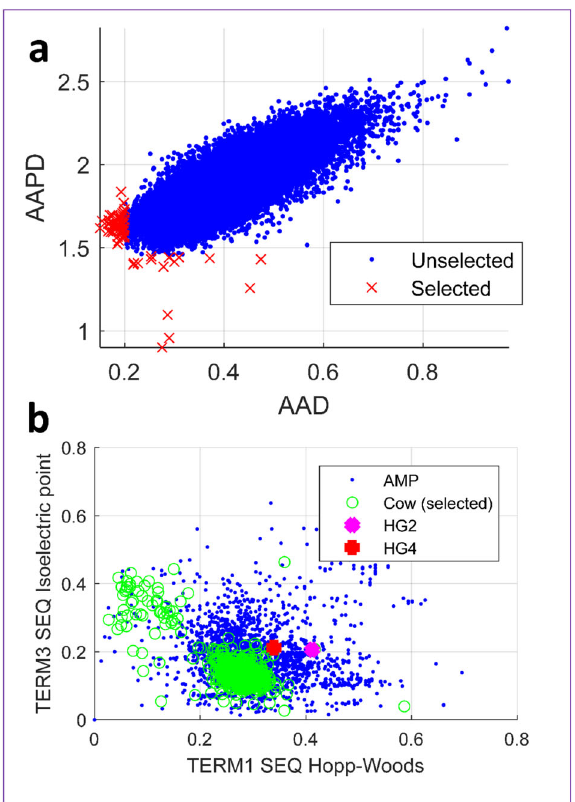
Fig. 1 In silico identi fi cation of peptides. a Visualisation of distances for AA acids (AAD) and AA pairs (AAPD) for the fi rst 68,274 sequences from library “ Cow ” 17 meeting the fi rst selection criteria: candidates with AAD <0.2 or AAPD <1.45 are selected as candidates (here: 65). b standard hydrophobicity (TERM1 SEQ Hopp- Woods) — loading (positively charged, TERM3 SEQ Isoelectric Point) plot. Blue dots are known AMPs (library ‘ AMP ’ consisting of AMPs from the APD2 45 and Hilpert Library 46 ), green coloured signs are AMP hits identi fi ed from library ‘ Cow ’ , and fi nally selected peptides HG2 (magenta) and HG4